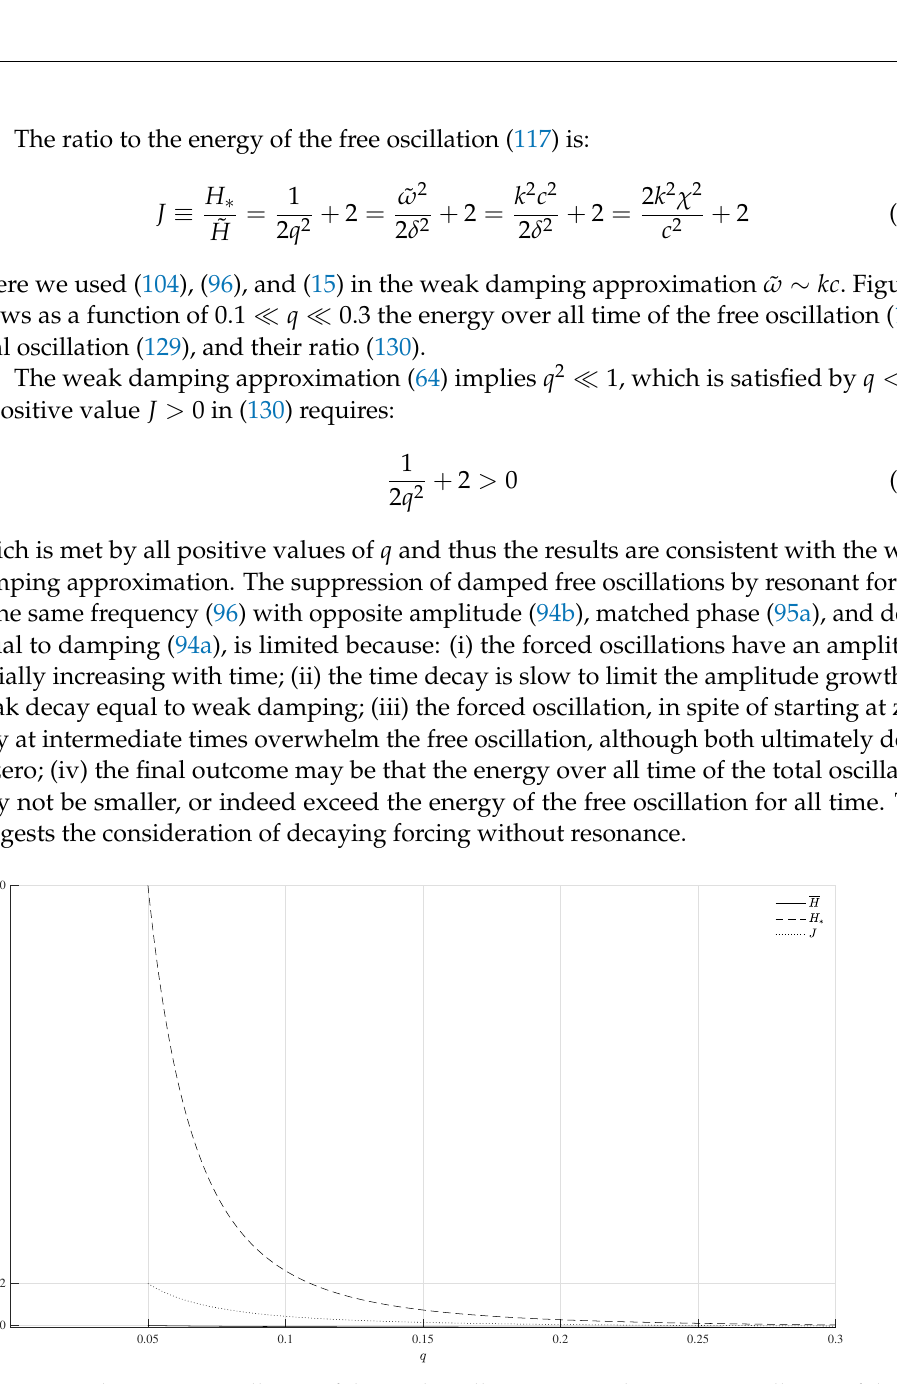
Figure 8. Total energy over all time of the total oscillation H ∗ , total energy over all time of the free oscillation ˜ H and the ratio J ≡ H ∗ / ˜ H , plotted as functions of the ratio of damping to oscillation frequency, q ≡ δ / ˜ ω